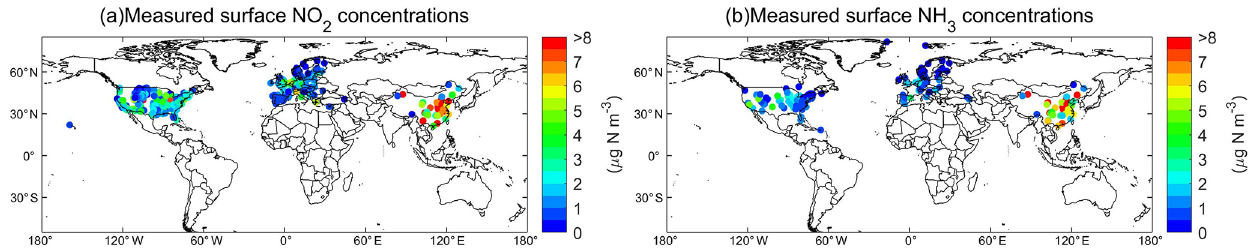
Figure 4. Spatial distribution of measured surface NO 2 and NH 3 concentrations in 2014. For NO 2 (a) , the measured data in China, the US and Europe were obtained from the NNDMN, US-EPA and EMEP, respectively; for NH 3 (b) , the measured data in China, the US and Europe were obtained from the NNDMN, US-AMoN and EMEP, respectively.